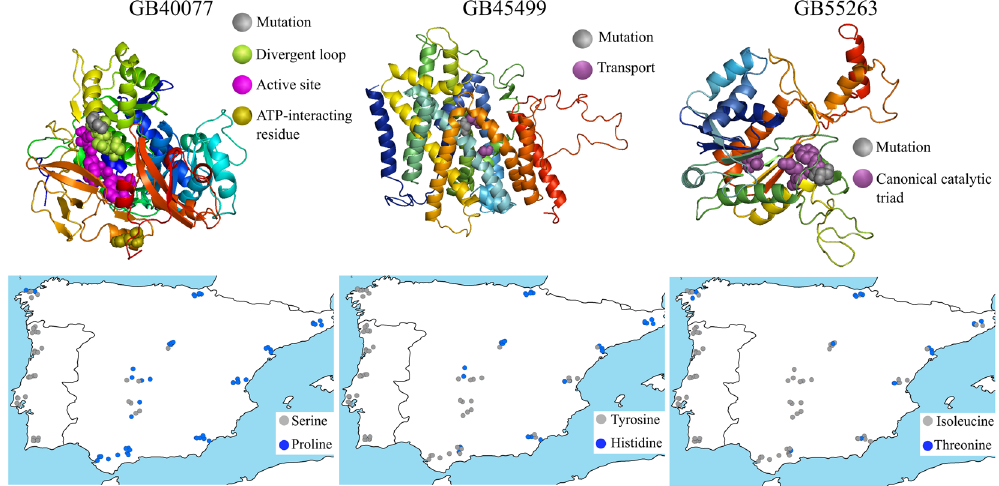
Figure 5. Predicted protein structures. The three genes harbour non-synonymous candidate SNPs, detected by three genome-wide methods, located nearby important places in the protein. The structures were predicted by Pymol considering the BeeBase reference amino acid sequences. The grey spheres represent the position and altered amino acids. The coloured spheres represent places with a known and important function in the protein. The maps depict the geographical patterns of the amino acids under